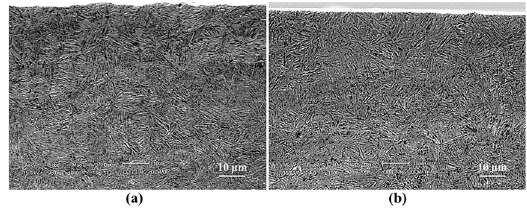
Figure 7. Microhardness profiles of the samples grinded in different conditions of cooling, and profile of the sample not